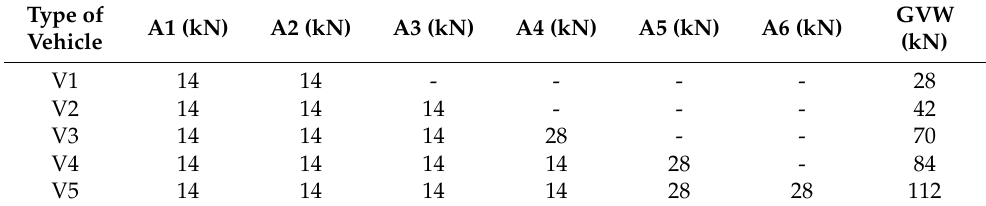
Table 2. Axle and gross weight for each vehicle.